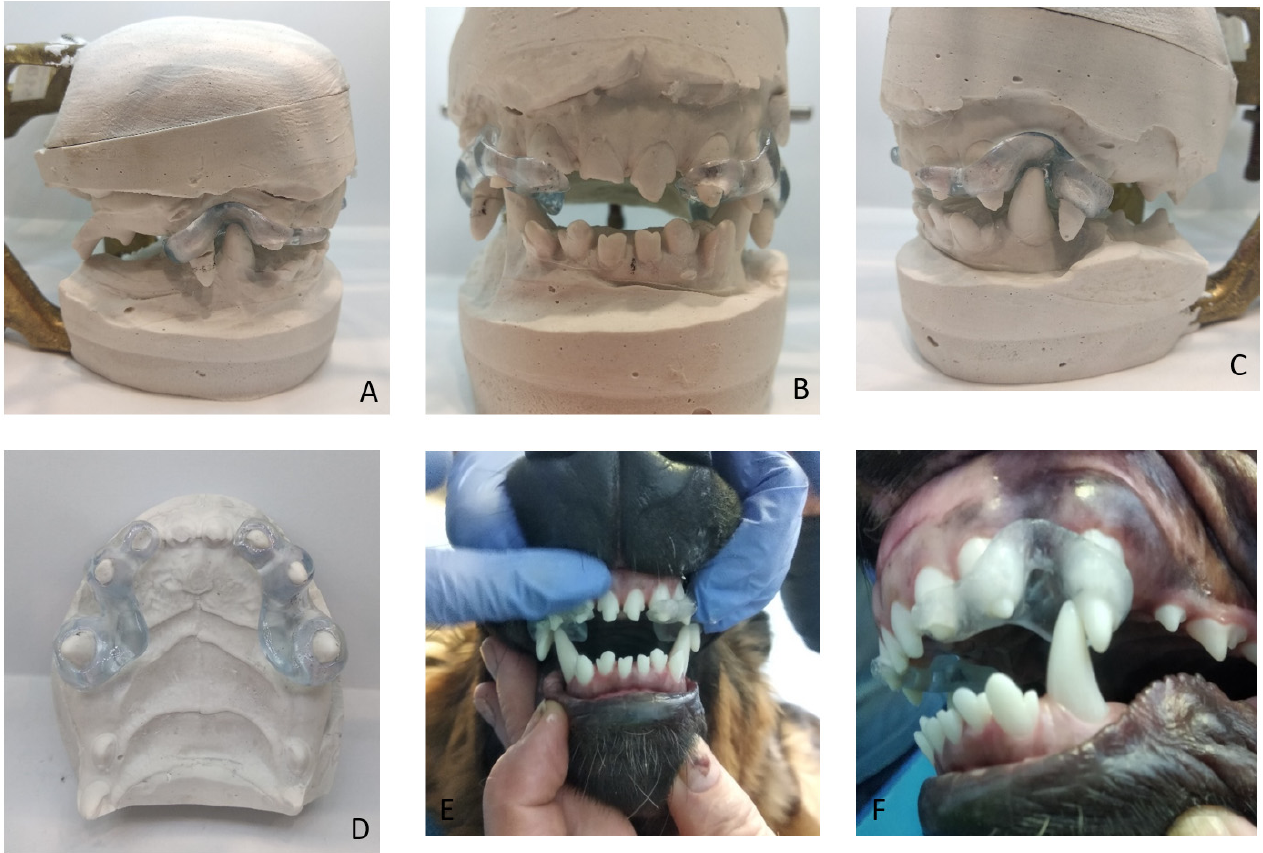
Figure 15. The cap appliance. On models ( A – D ) and after cementing ( E , F ). In the third case, an adjusted plate of a spring appliance was used, mainly based on the top plate of the Stockfisch appliance with its active tongue loops, on which a rubber hose was stretched and secured against slipping. This provoked the desire to bite forwards (Figure 16) and increased muscle tension (Figure 17). The owner noticed that the flews were tenser after treatment in comparison to the state before the treatment.